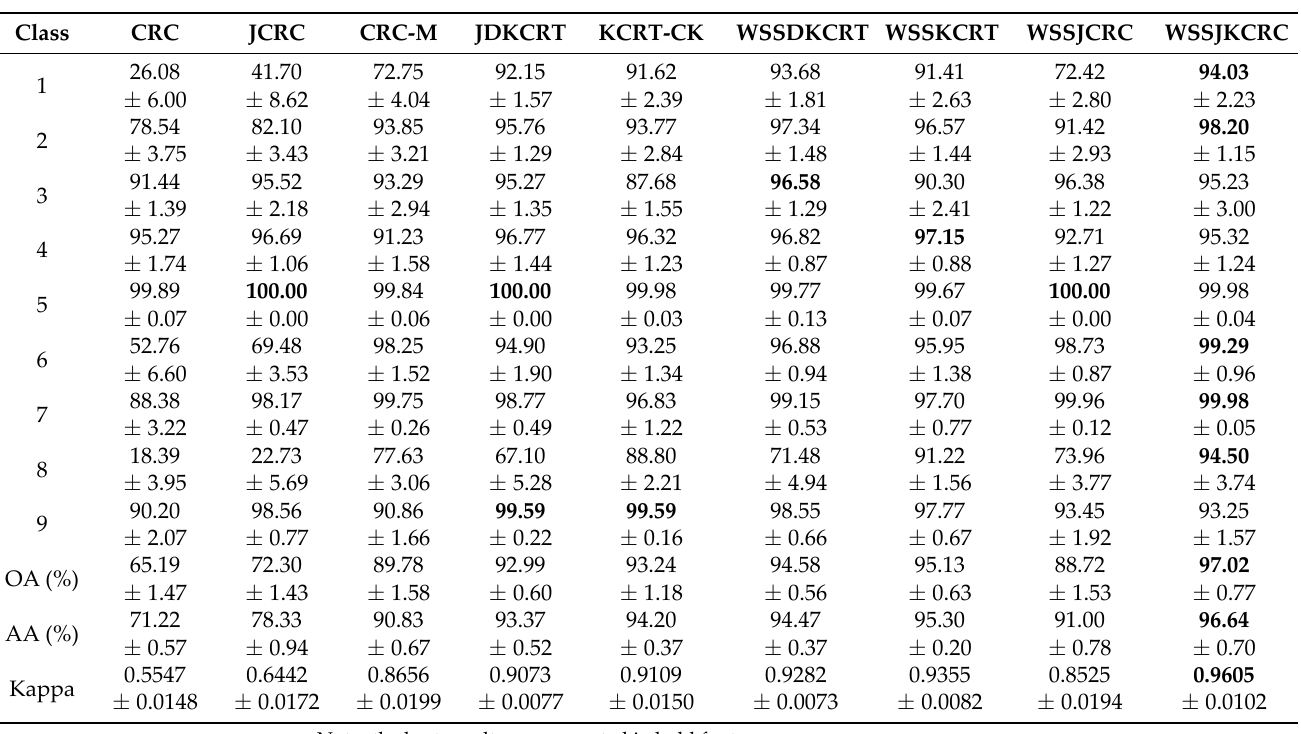
Land cover classification accuracy with STD for different methods on the Pavia